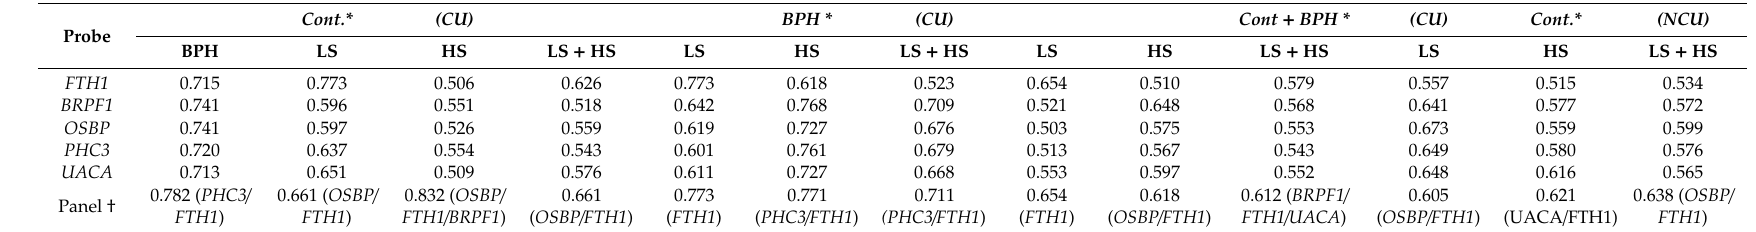
Table 2. ROC analysis of selected mRNA